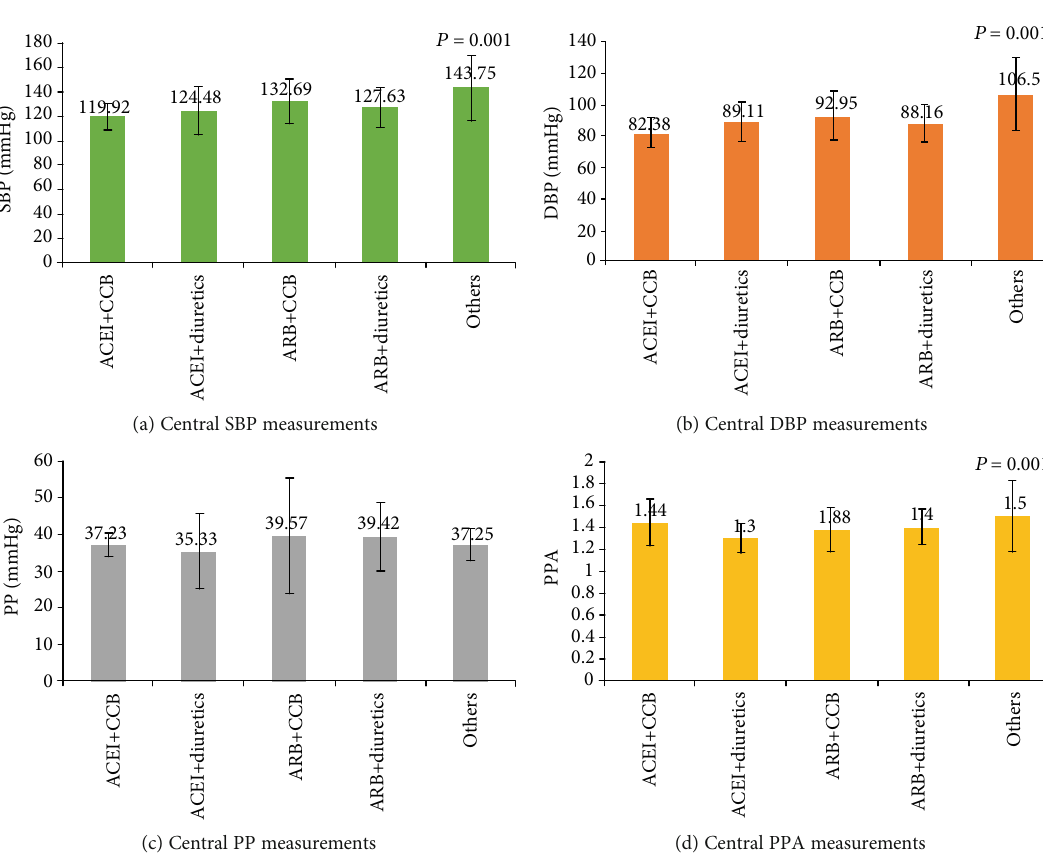
Figure 2: Central blood pressure measurements among various antihypertensive drug combinations. SBP: systolic blood pressure; DBP: diastolic blood pressure; PP: pulse pressure; PPA: pulse pressure augmentation. Table 5: Measurement of vascular